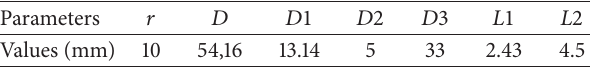
Table 11: Dimensions of the miniaturized 3D spherical antenna (Figure 18).